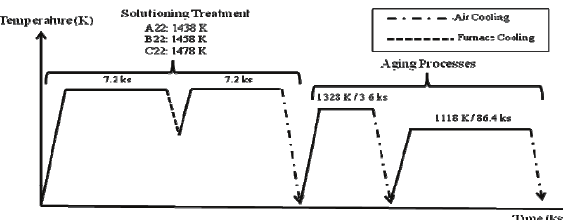
Figure 7. Simulated reheat treatment programs: A22, B22 and C22.